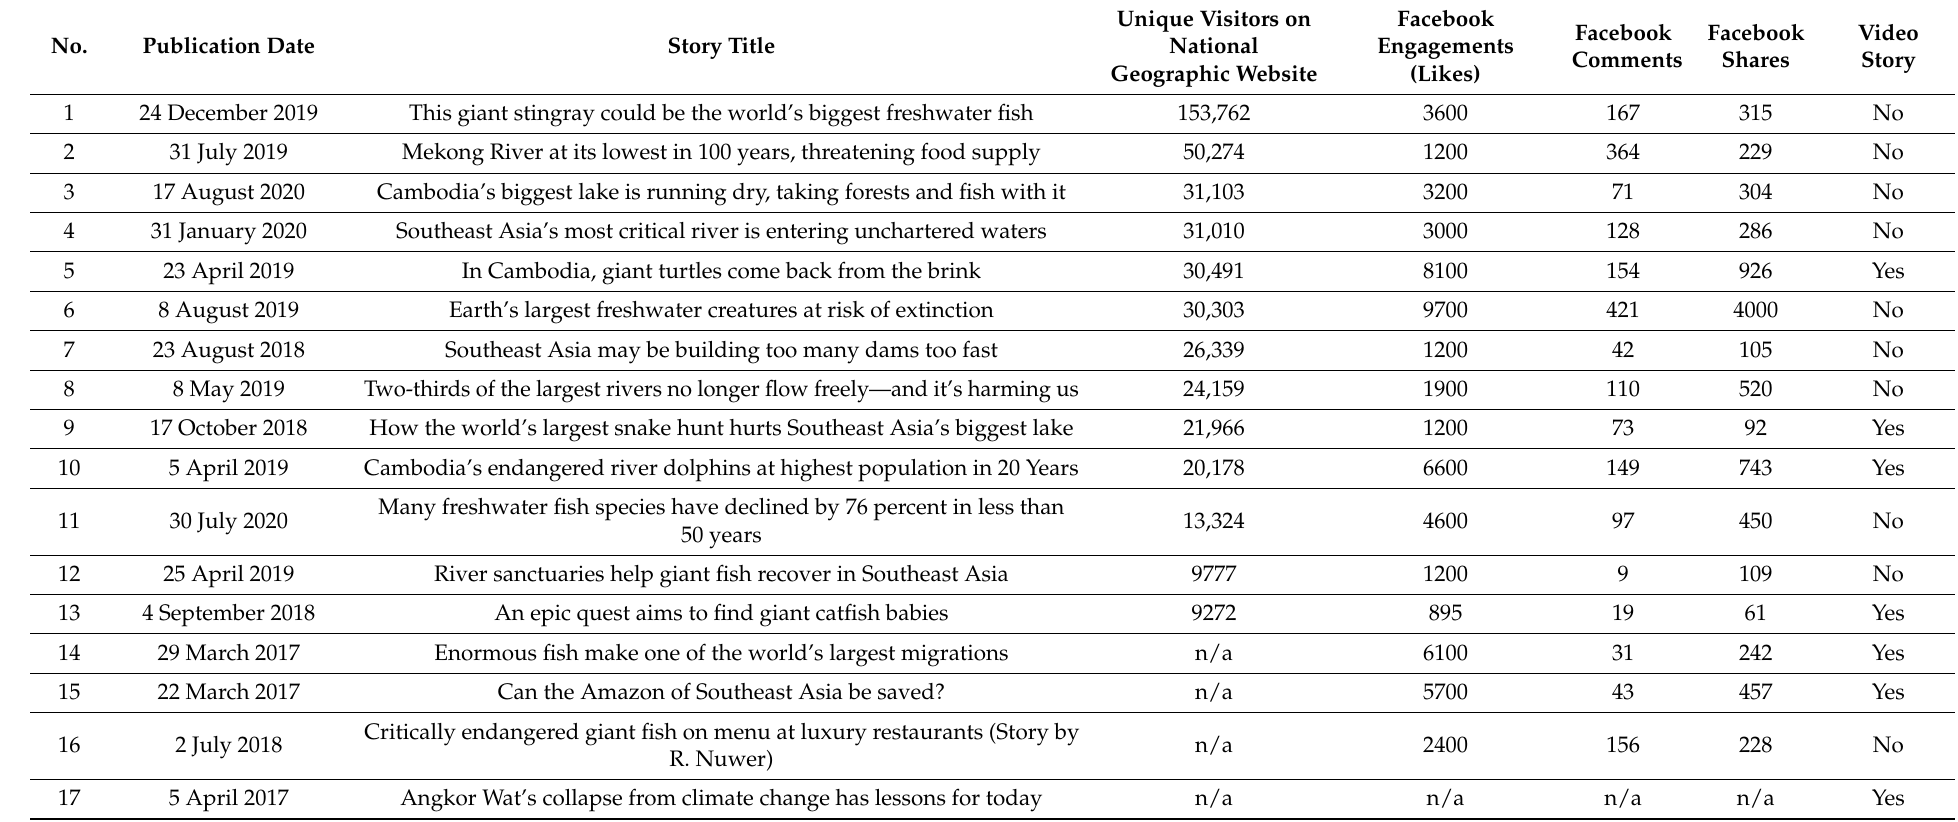
Table 2. Engagement metrics of recent National Geographic stories about Mekong River topics, ranked by number of website visitors.